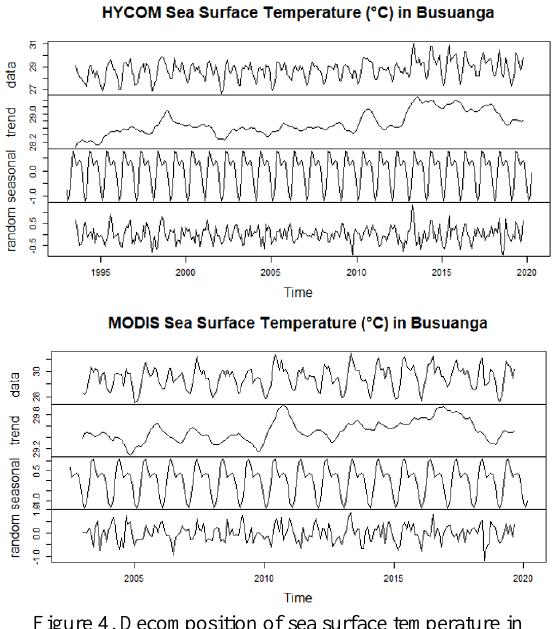
Figure 4. Decomposition of sea surface temperature in Busuanga from HYCOM and MODIS